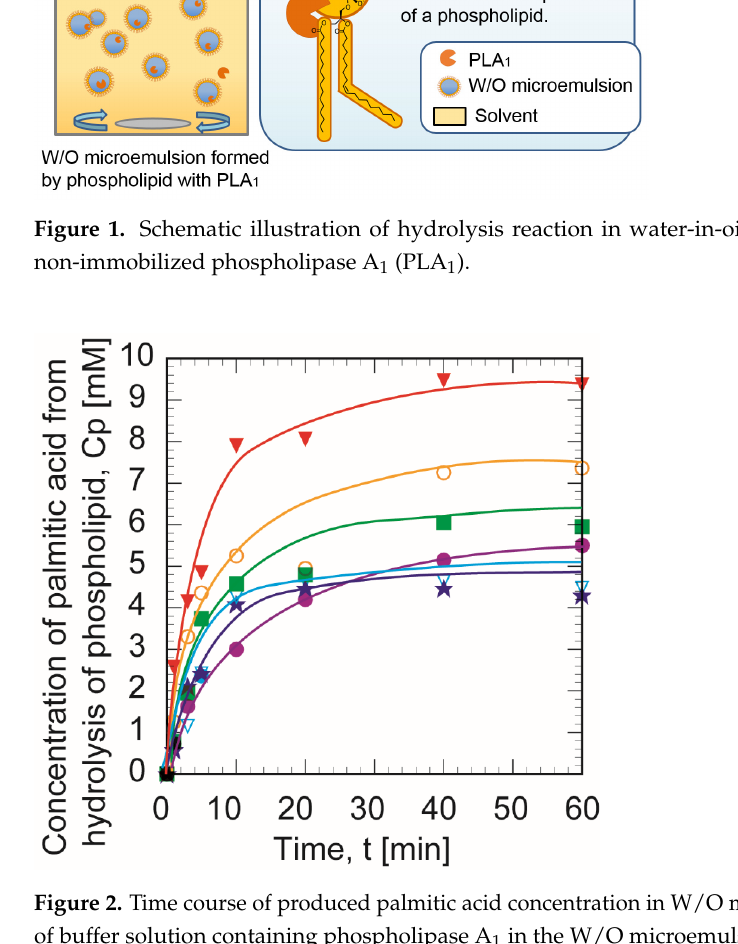
Figure 1. Schematic illustration of hydrolysis reaction in water-in-oil (W/O) microemulsion of non- immobilized phospholipase A 1 (PLA 1 ).